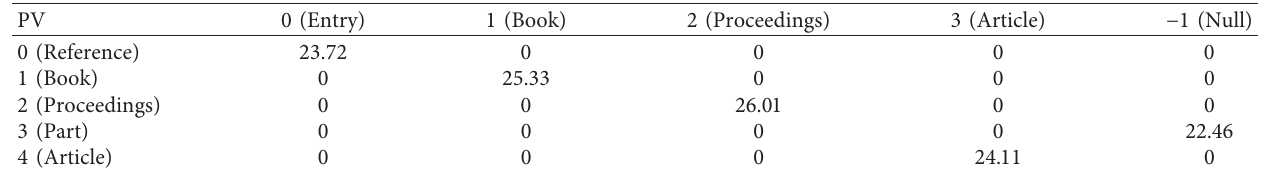
Table 2: An example of convergent PV.